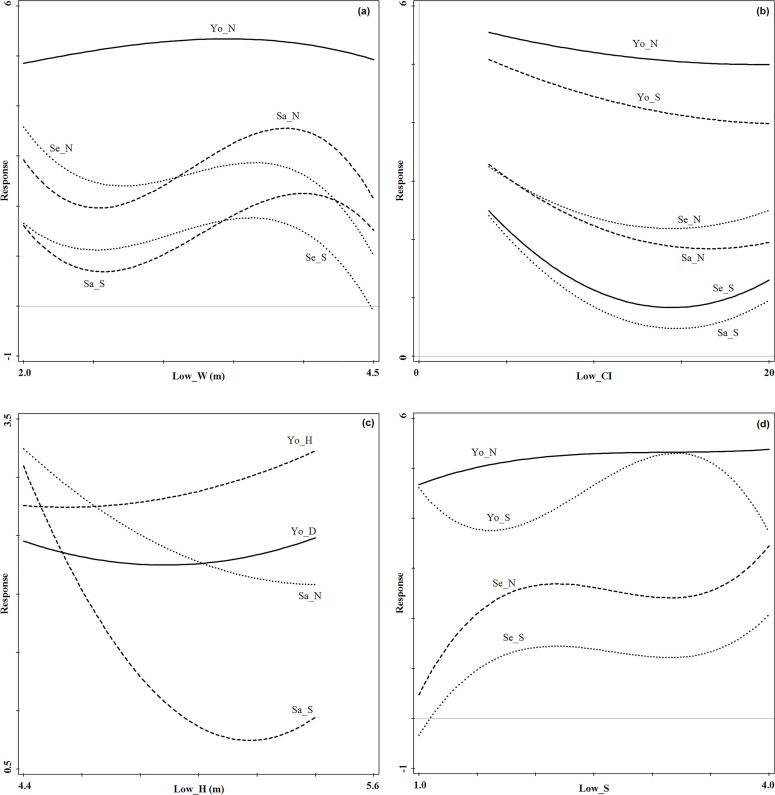
Regeneration response curves to the most important lower forest
stratum structure indices in the evergreen broad-leaved forest (Fig
10A: Low_W; Fig 10B: Low_Cl; Fig 10C: Low_H; Fig 10D: Low_S). Se_N
and Se_S denote seedling density and tree species richness index,
respectively; Sa_N and Sa_S denote sapling density and tree species
richness index, respectively; Yo_N, Yo_D, Yo_H and Yo_S denote young
tree density, diameter at breast height, tree height and tree
species richness index, respectively.